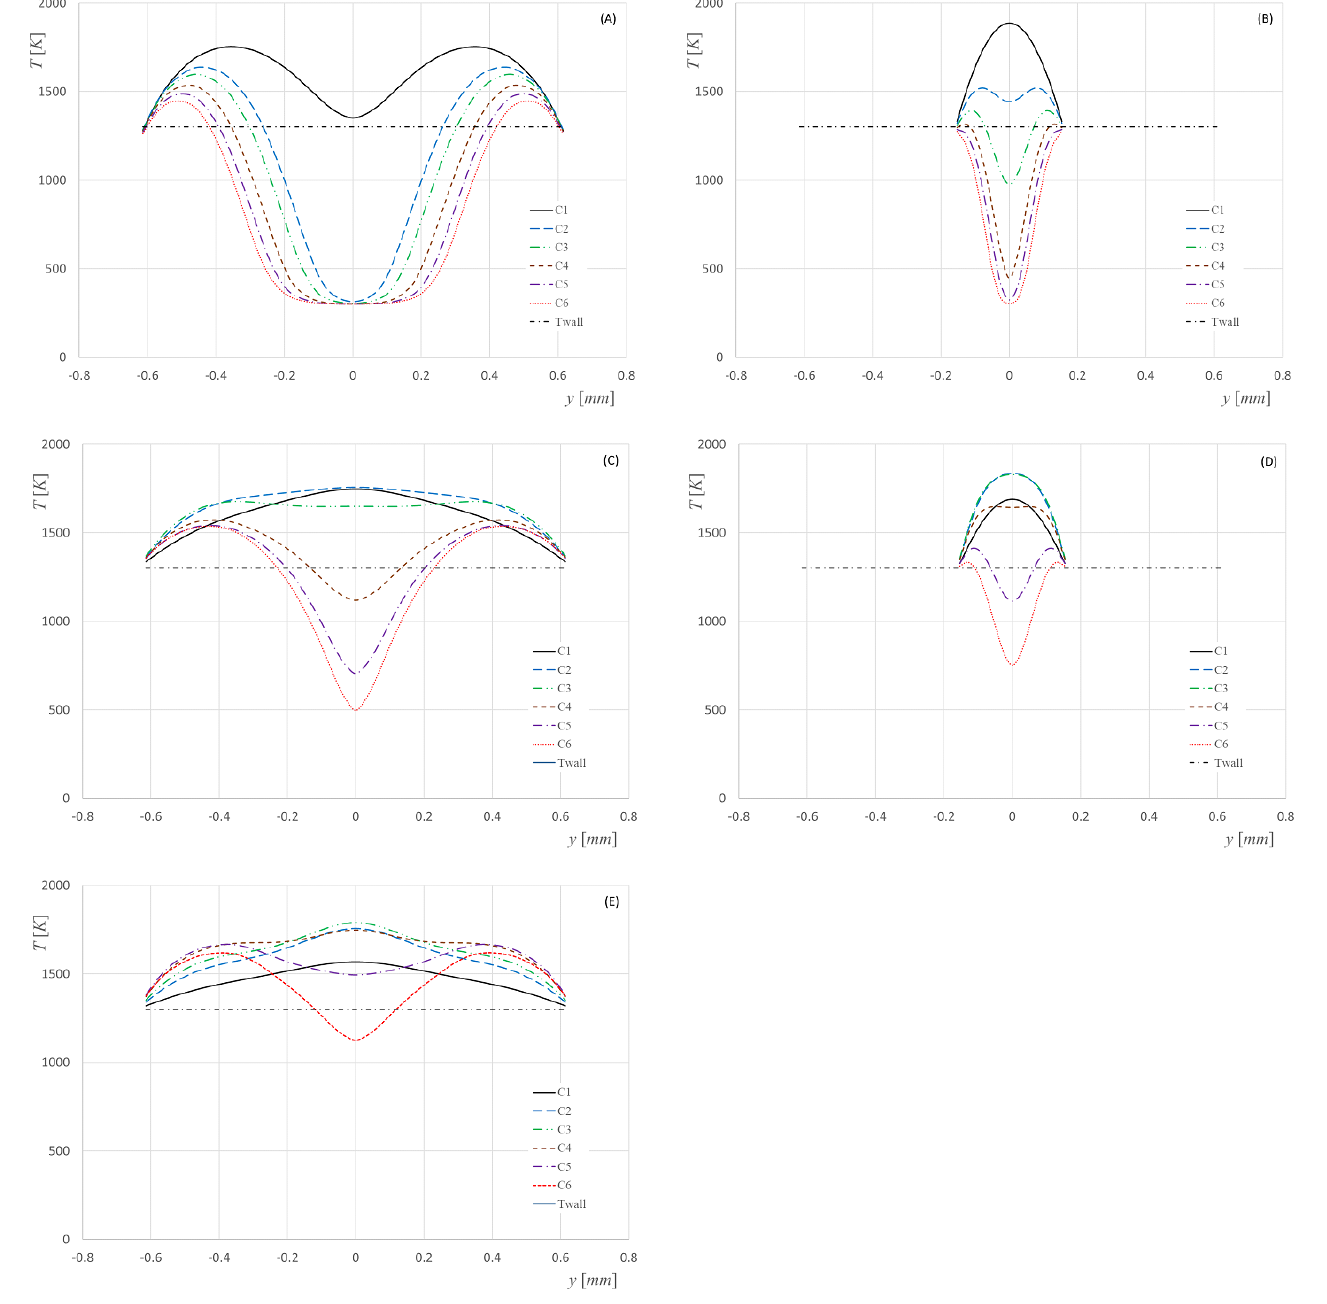
Figure 9. Temperature profiles across the burner for all cases. ( A ): x = 2.5 mm; ( B ): x = 3.5 mm; ( C ): x = 4.5 mm; ( D ): x = 5.5 mm; ( E ): x = 6.5 mm. In terms of pollutant emissions, C1 presented a higher NO x value of 4.25 ppm versus 3.32 ppm for case R1, due to the complete consumption of hydrogen in the